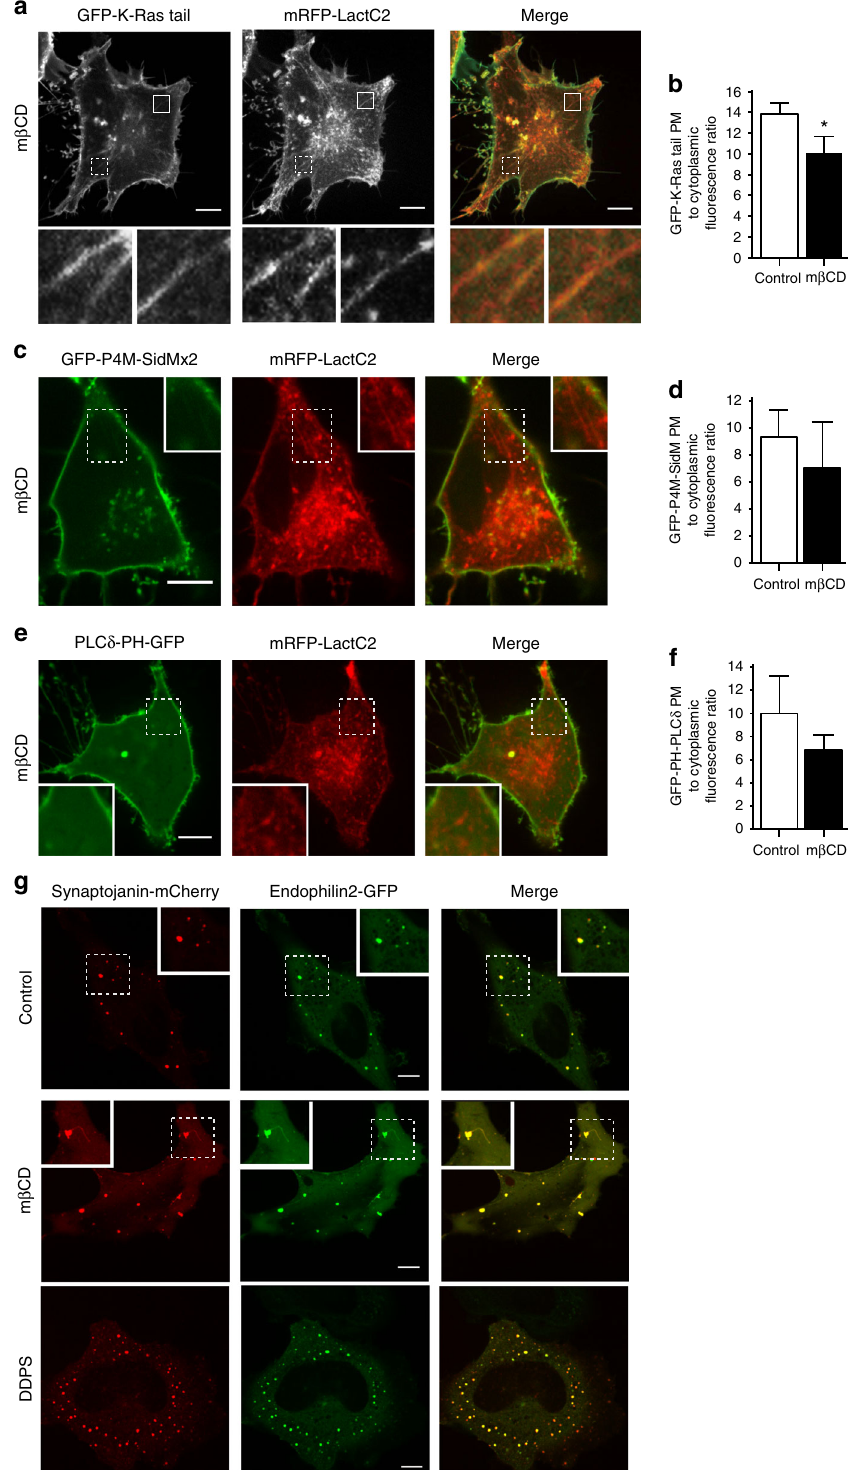
Fig. 6 Acute removal of cholesterol forms PtdSer-rich tubules. a Confocal images of following m β CD treatment of HeLa cells co-transfected with mRFP- LactC2 and GFP-K-Ras tail. Lower left insets: magni fi cation of the areas indicated by a dashed square. Lower right insets: magni fi cation of areas indicated by a lined square. b Quantitation of the distribution of GFP-K-Ras tail between the plasma membrane and the cytoplasm 20 min after the addition of m β CD. Data are means ± s.e.m., n = 14. c , e m β CD treatment of HeLa cells co-transfected with mRFP-LactC2 and either the PtdIns4P probe GFP-P4M-SidMx2 or the PtdIns4,5P 2 probe GFP-PLC δ -PH. Insets: magni fi cation of the areas indicated by a square. d , f Quantitation of the distribution of GFP-P4M-SidMx2 or GFP-PLC δ -PH between the plasma membrane and the cytoplasm 20 min after the addition of m β CD.Values represent the means ± s.e.m., n = 11. g Confocal images of control, DDPS and acute m β CD-treated HeLa cells co-expressing Synaptojanin2-mCherry and Endophilin2-GFP. NS = not signi fi cantly different, *p < 0.05, **p < 0.01 and ***p < 0.005; as determined using a two-tailed t-test. Scale bar = 10 µ